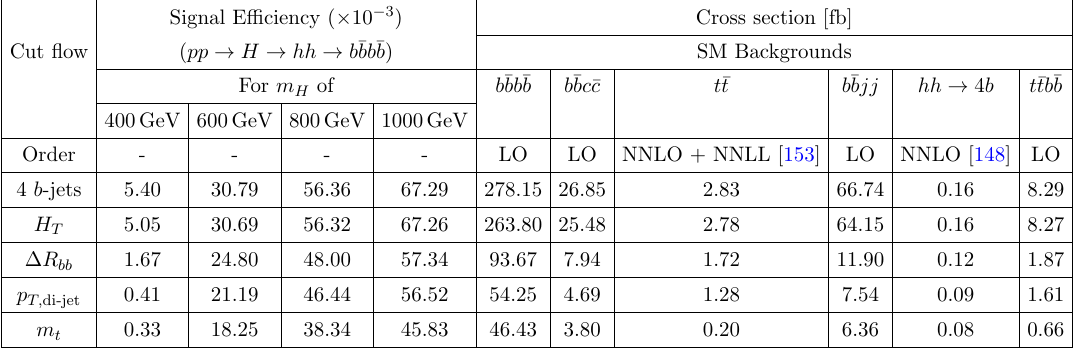
succession. We generate the t (cid:22) t background with the top quark decaying to a b -quark and a W -boson. The W -bosons are then further decayed to c (cid:22) s or (cid:22) cs . We avoid the W u (cid:22) d ! mode as the probability of a light jet faking a b -jet is 10 times smaller than that of a (cid:24) c -jet. Lastly, we also consider the subdominant background coming from the non-resonant di-Higgs production ( gg hh ) and also from t (cid:22) tb (cid:22) b (including t (cid:22) tZ=t (cid:22) th !